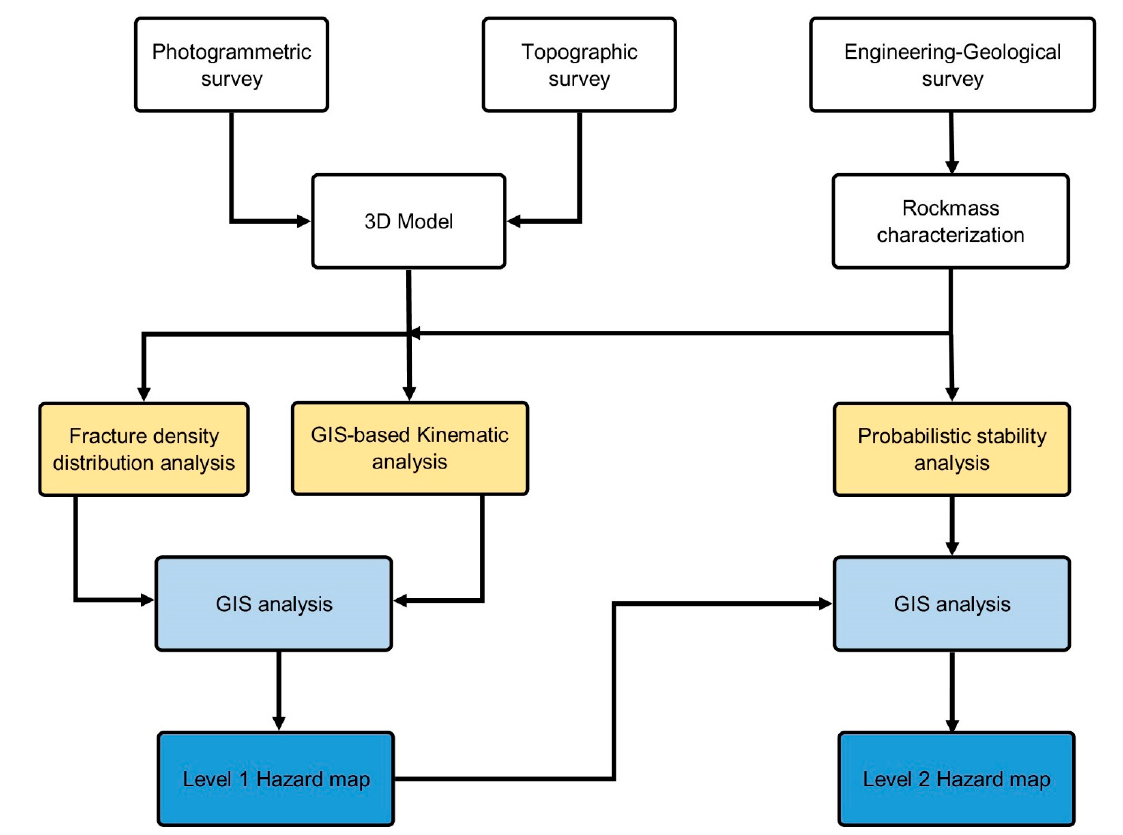
Figure 5. Flowchart of the proposed rockfall hazard